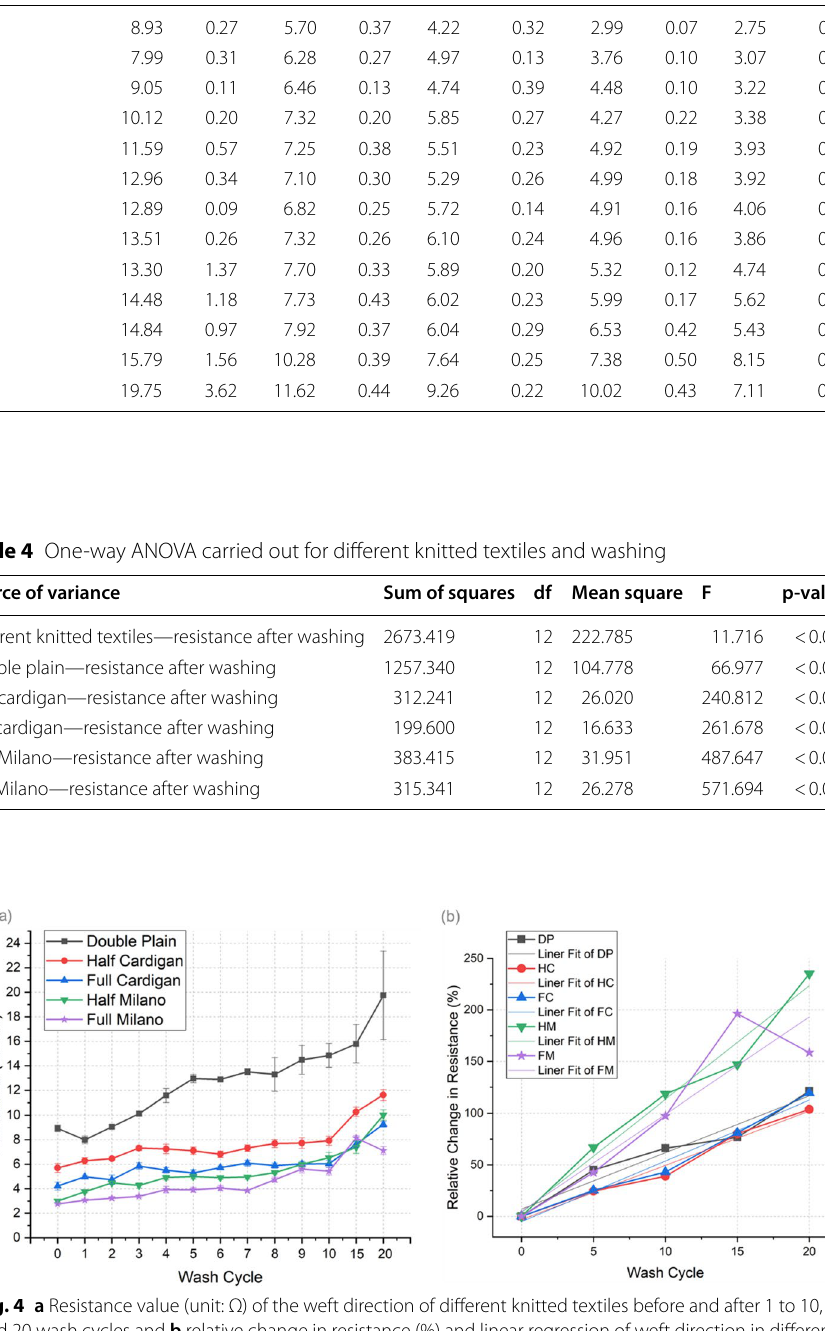
Table 3 The resistance values (unit: Ω) in the weft direction of the five knitted textiles with their before and after values for 1 to 10, 15 and 20 wash cycles Resistance (Ω/inch) Knitted textile Double plain Half cardigan